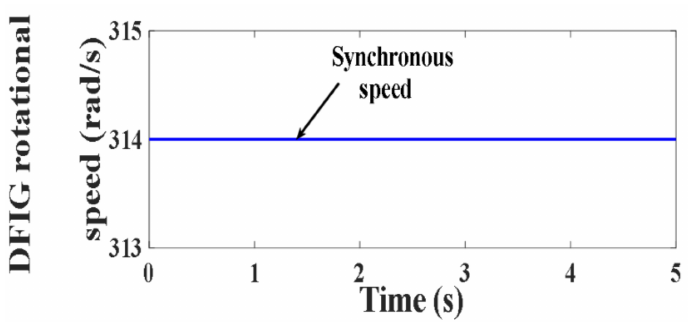
Figure 119. Prime mover operating speeds (rad/s).